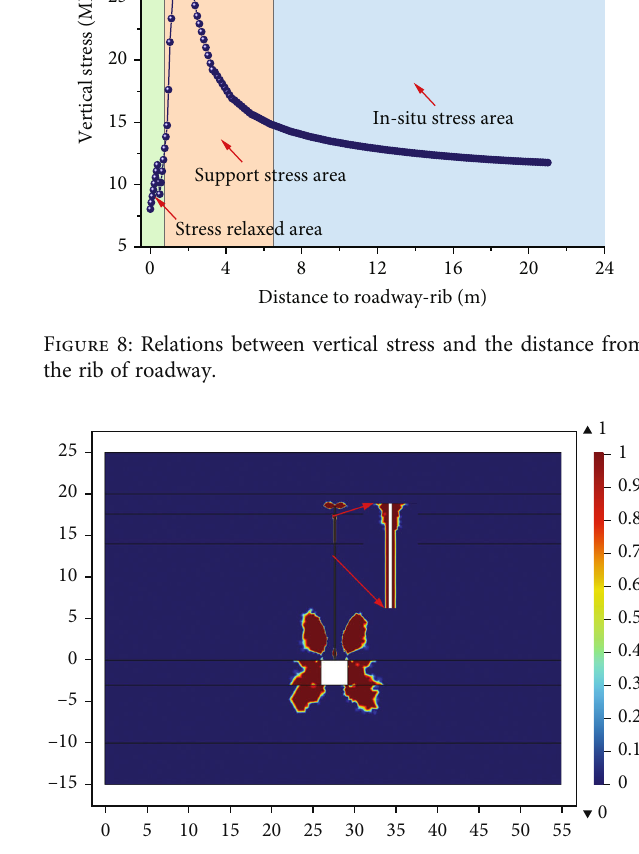
Figure 9: Plastic zone distribution of surrounding